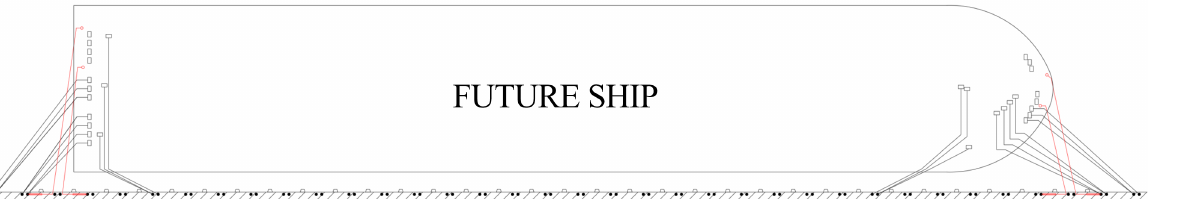
Figure 23. Future vessel position of the 100 t ShoreTension ® when replacing lines in the breast lines (red lines).